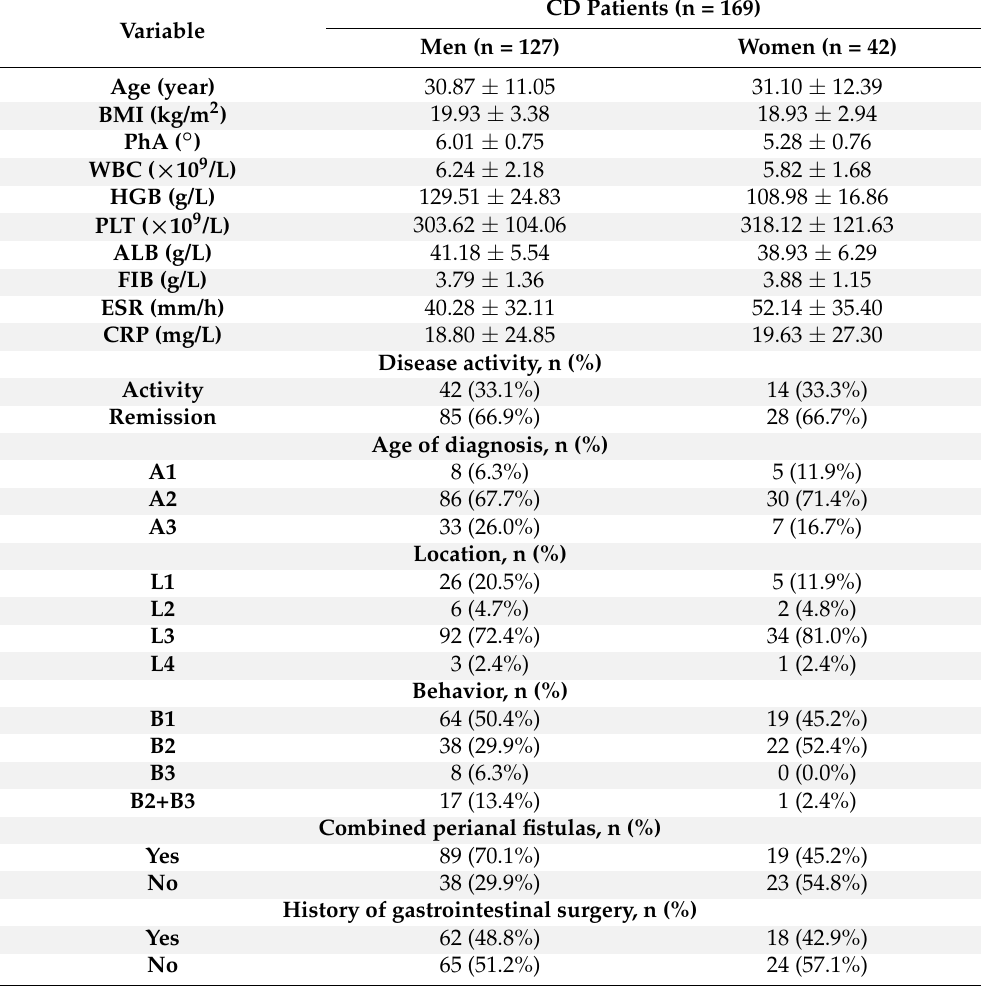
Table 1. Demographic, anthropometric, body composition, and clinical data of CD